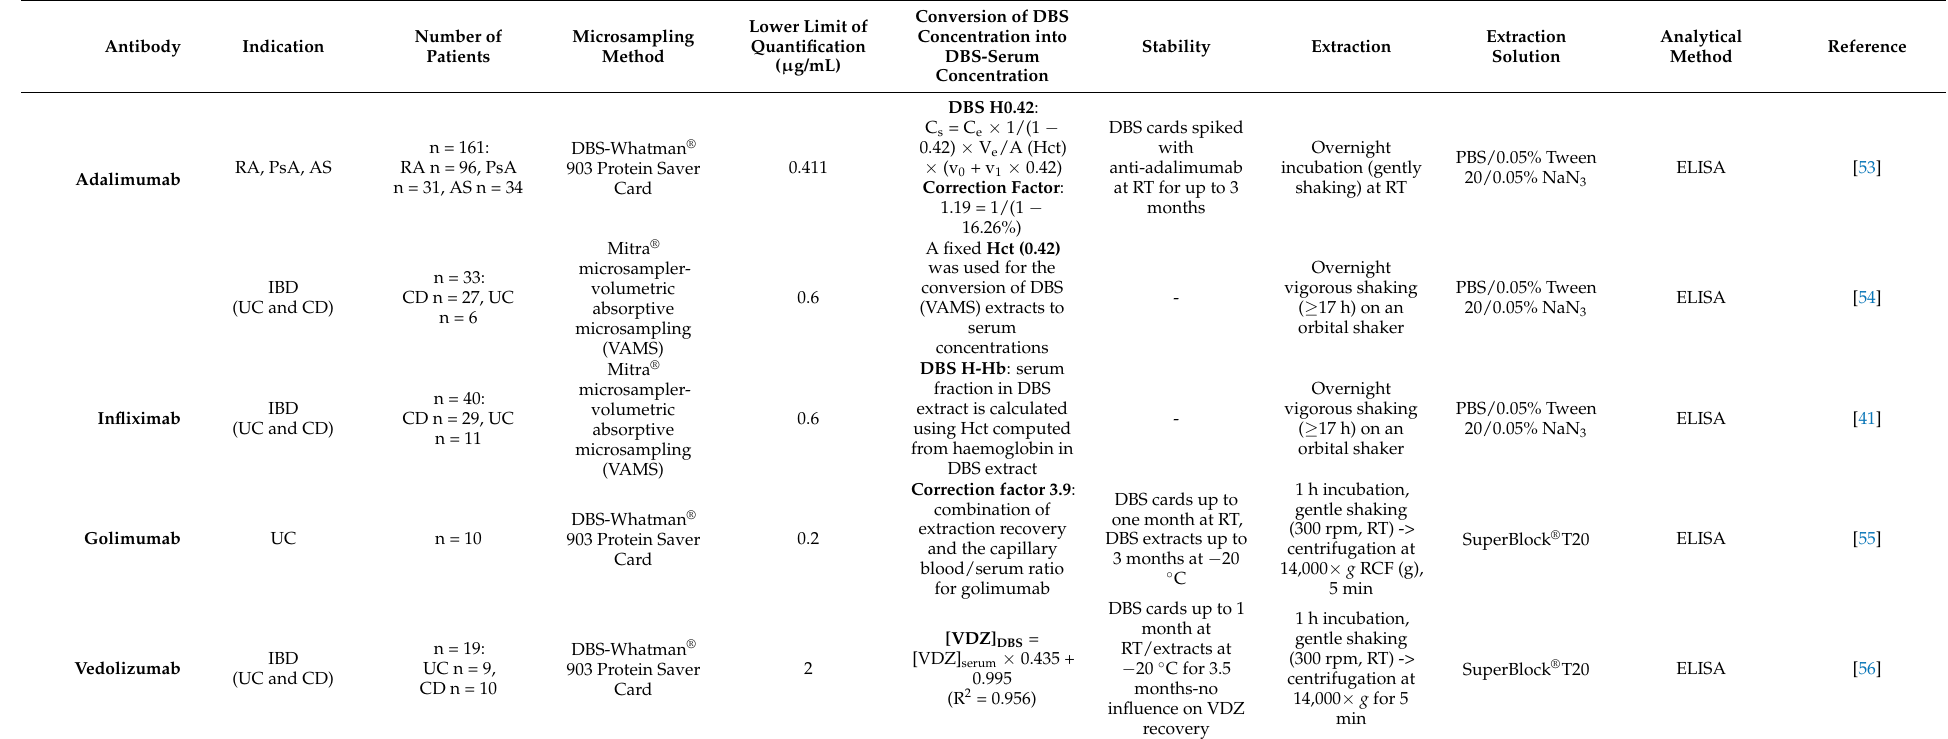
Table 2. Summary of studies utilizing microsampling for the TDM of